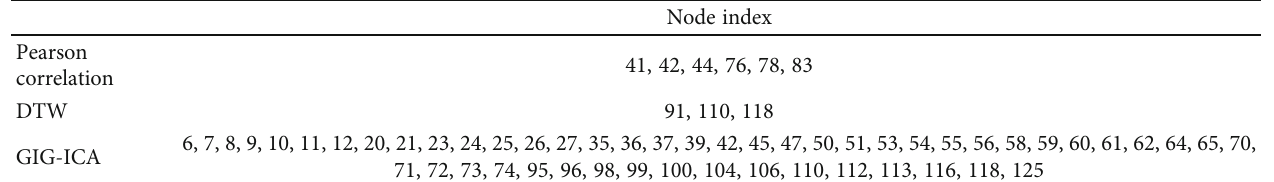
Table 7: rs-FC network nodes which exhibit signi fi cant groupwise di ff erence across HC, MCI, and AD groups.